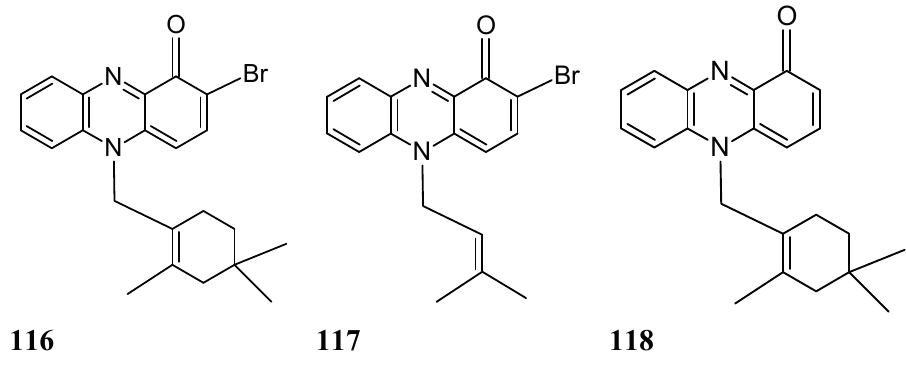
Figure 40. Phenazineanalogs 116 – 118 .